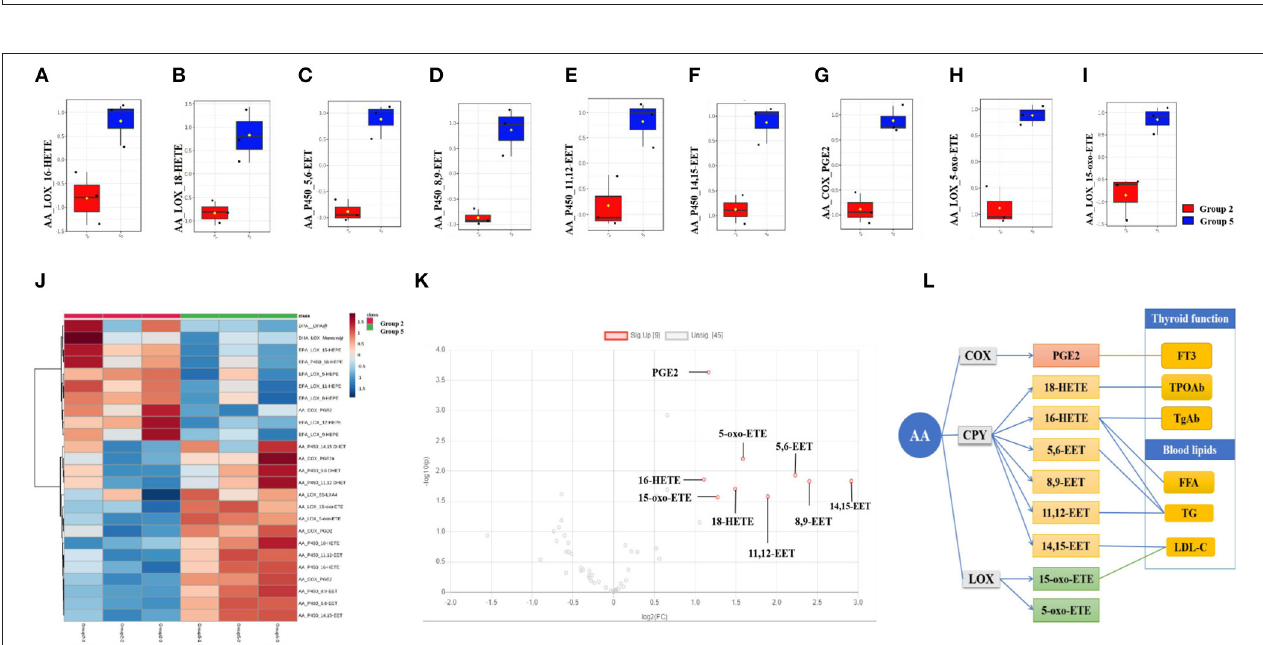
FIGURE 4 | Echocardiography data. (A,B) Representative examples of M-mode and B-mode echocardiographic tracings from group 1 (control) and group 2 (continued 100 HI administration). (C–G) Measurements were assessed by the echocardiographic data. * p < 0.05. (H) Systolic blood pressure (SBP). LVAW, left ventricular anterior wall. n = 6 for each group.